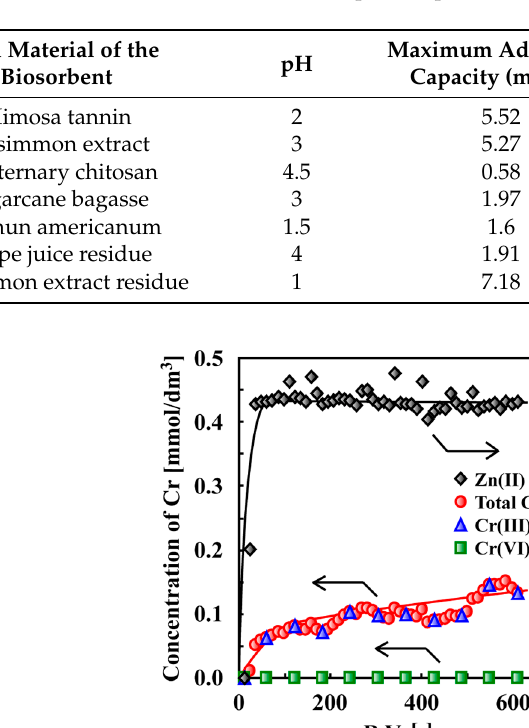
Table 4. Maximum Cr(VI) adsorption capacities for different biosorbents.